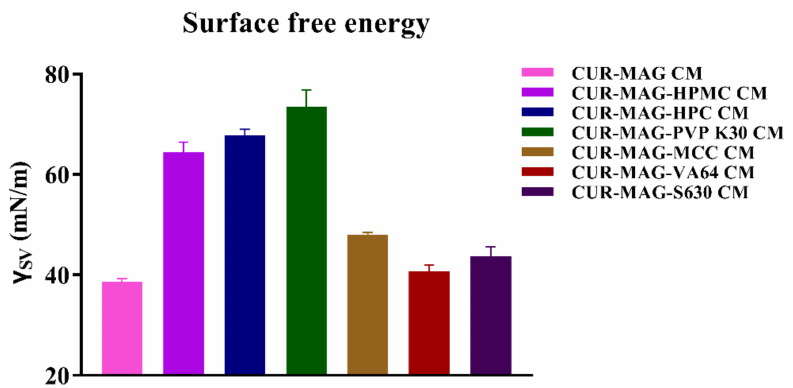
Figure 9. Surface free energy of co-amorphous samples calculated according to van Oss